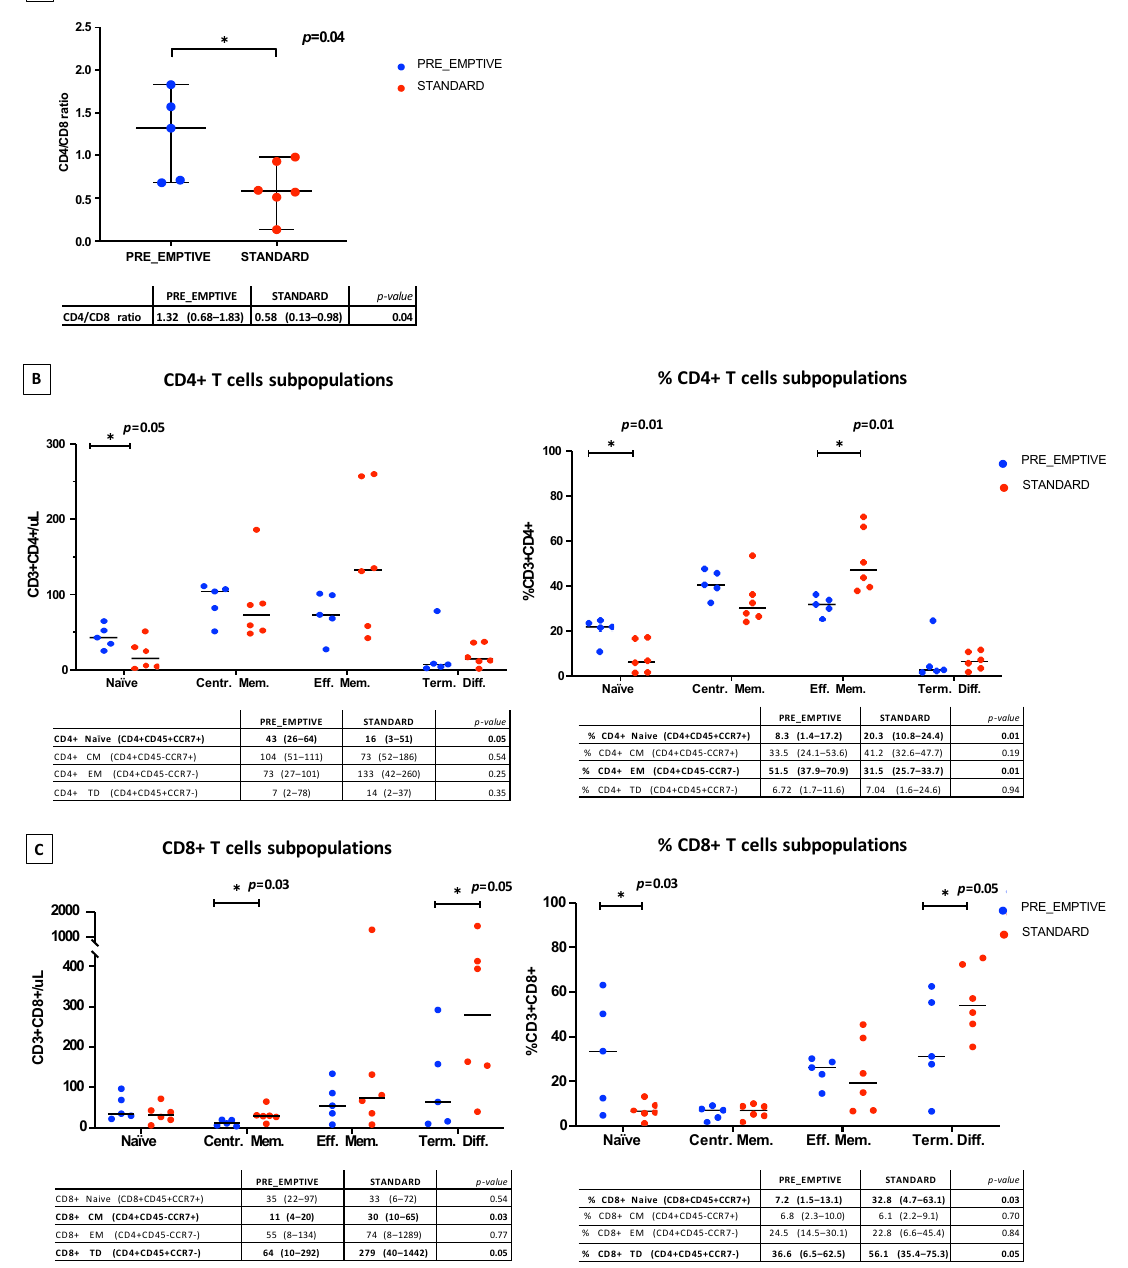
Figure 2. Ly-subsets in DLBCL patients who received “pre-emptive” (blue) or standard Ly-apheresis (red). ( A ) CD4+/CD8+ ratio. ( B ) CD4+ T cell subpopulations evaluated as absolute counts (cells/ µ L) and as a percentage. ( C ) CD8+ T cell subpopulations evaluated as absolute counts (cells/ µ L) and as a percentage. * = statistical significance (i.e., p <